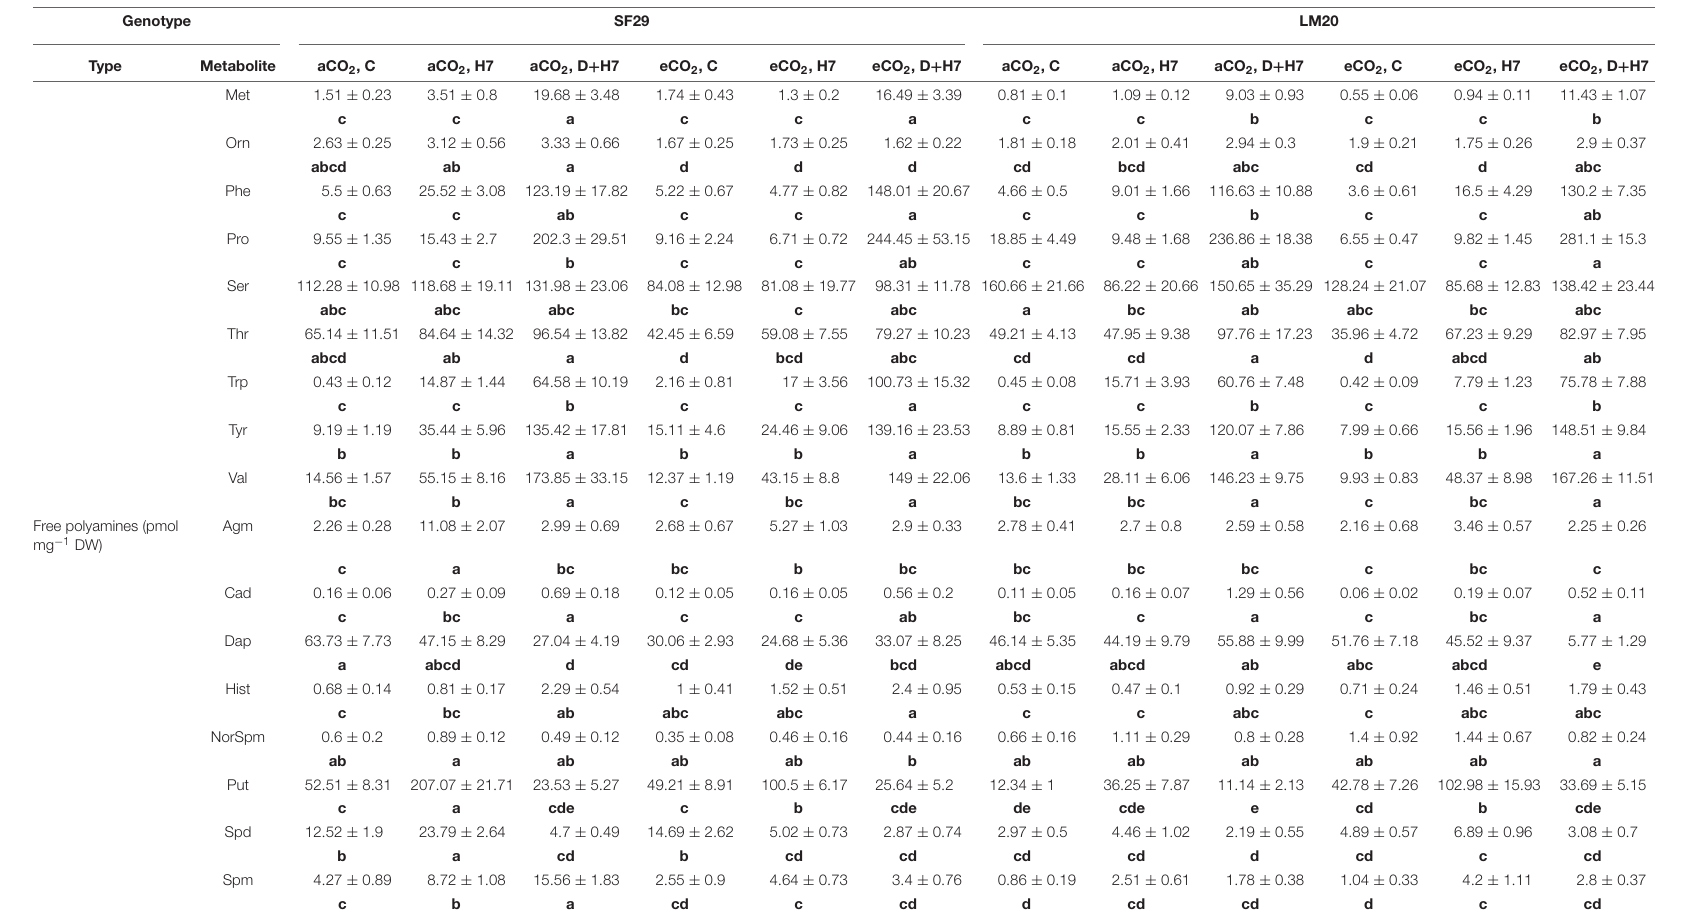
The data represent mean values ± standard error (S.E.). Different small letters indicate significant differences within variants according to Duncan’s test after ANOVA (P <